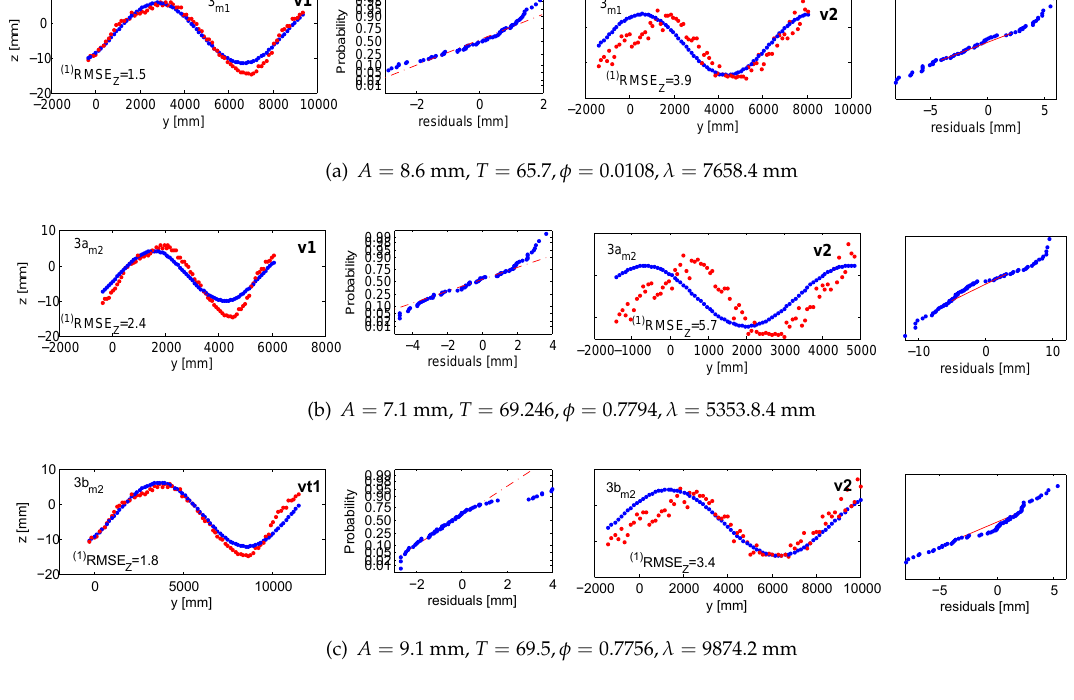
Figure 15. Accuracy 1 validation results in the third measurement series for m 1 in ( a ) and m 2 in ( b ) and ( c ), compared against the response of vt 1 and vt 2. Ground truth in red; fitted wave model in blue. The normal probability plots are in even columns.